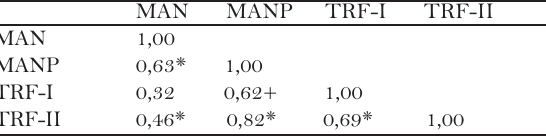
Índices de Correlação de Postos de Sperman (Sr) entre os Desempenhos Cognitivos na Manutenção Imediata (MAN), Manutenção